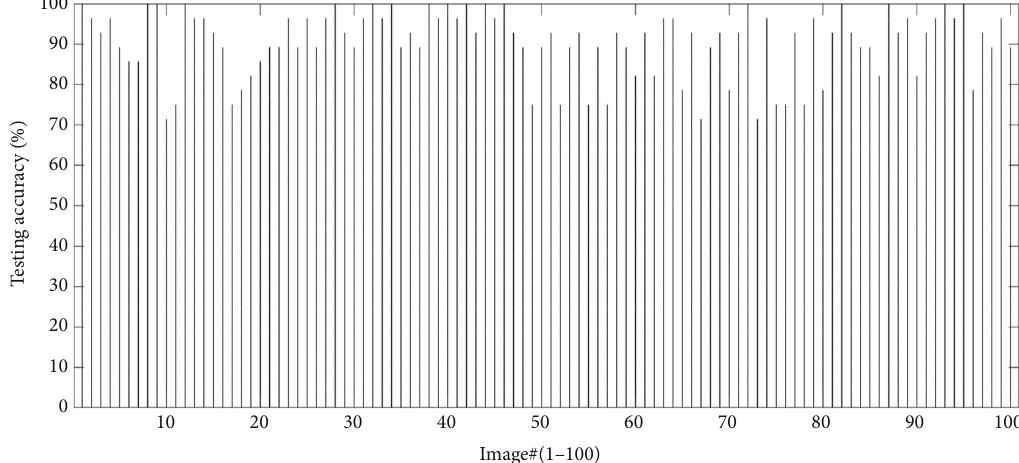
Figure 8: Testing accuracies of 100 new images, and the average accuracy is